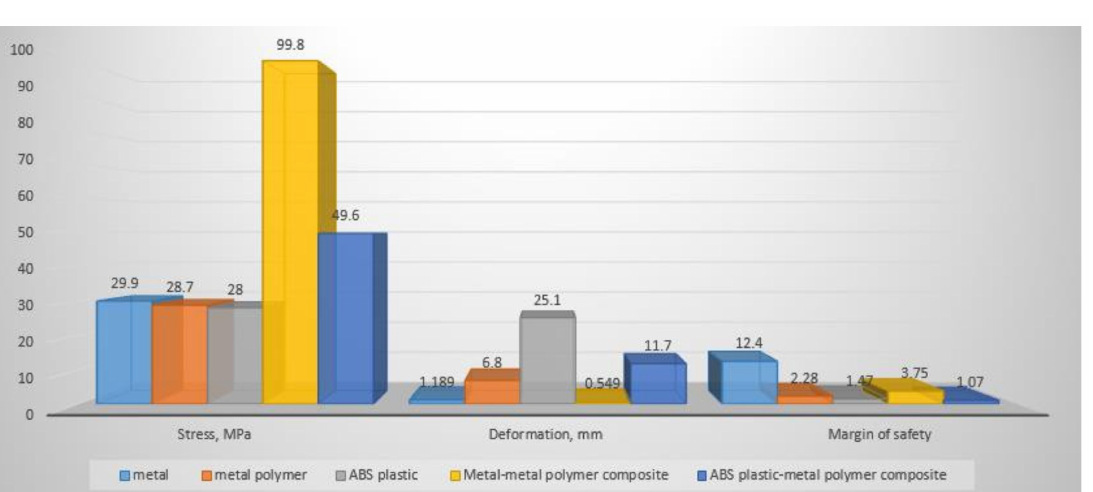
Figure 12. Comparison of strength characteristics of specimens under a load of 2000 N manufactured using various